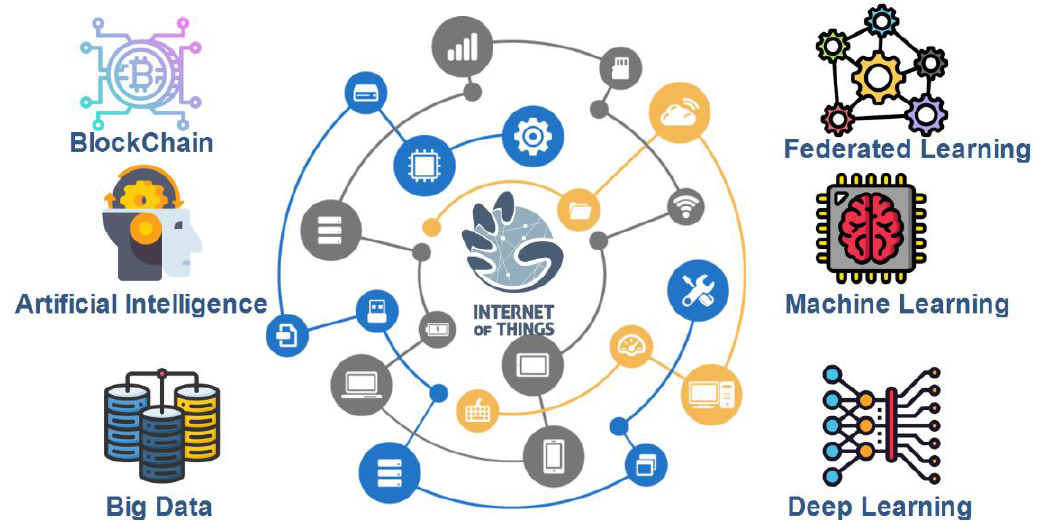
Figure 2. The connecting technologies in the IoT.